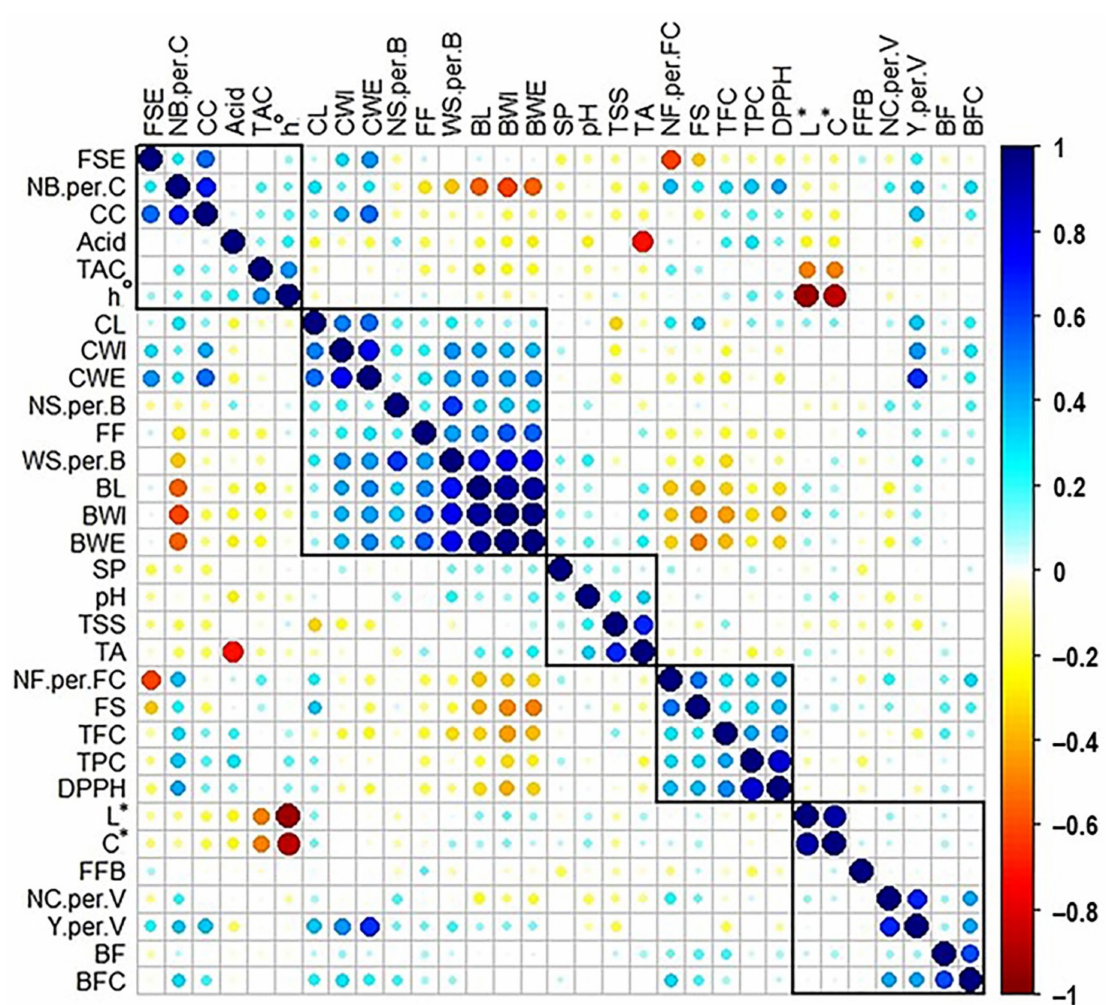
Figure 9. Pairwise Pearson correlation matrix of the fertility-related traits along with physical cluster- and berry-related traits [16], biochemical-, color-, and nutraceutical-related traits [17,18] in muscadine population ( n = 90). By using hierarchical clustering, rectangles were drawn around traits data. Data are presented as an average from three biological replicates for three consecutive years. For the fertility-related traits; first fruiting bud (FFB), bud fertility (BF), bud fertility coefficient (BFC), number of flowers per flower cluster (NF.per.FC), fruit-set efficiency (FSE), number of clusters per vine (NC.per.V), and yield per vine (Y.per.V). The previously characterized traits include flower structure (FS), cluster length (CL), cluster width (CWI), cluster weight (CWE), number of berries per cluster (NB.per.C), cluster compactness (CC), berry length (BL), berry width (BWI), berry weight (BWE), number of seeds per berry (NS.per.B), weight of seeds per berry (WS.per.B), firmness (FF), scar pattern (SP), total soluble solids (TSS), titratable acidity (Acid), TSS/acid ratio (TA), pH, total anthocyanin content (TAC), luminosity index (L*), hue angle (h ◦ ), chroma index (C*), total phenolic content (TPC), total flavonoid content (TFC), and the 2,2-diphenyl-1-picryl-hydrazyl-hydrate (DPPH). The color change is proportional to the correlation level (see the color scale). The positive correlation is displayed in cyan and blue, the negative correlation in yellow and